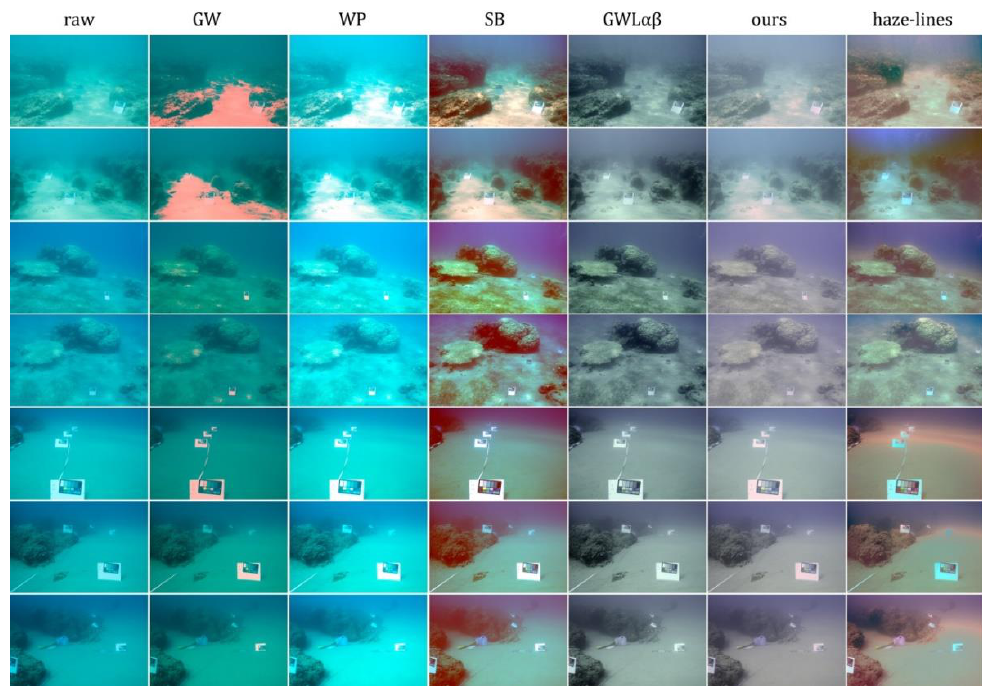
Figure 11. Comparisons on images in Haze-line dataset [13]. From left to right are raw underwater images, the results of gray-world (GW) method, white-patch (WP) method, statistical-based (SB) method [21], Bianco’s (GWLαβ) method [37], proposed method and haze-lines method [13]. Lower angular error indicates a more accurate color restoration. Many images in the Haze-line dataset contain multiple color charts at different distances from the camera. The charts are ordered by its distance to the camera and chart #1 is closest to the camera. The angular errors for each chart, image, and method are shown in Table 1. The lowest average angular error is got by our method, as evident from Table 1. Table 1. Angular error (unit: degrees) in RGB space between the gray-scale patches and a pure gray color, for each chart in each image, and all methods. Lower is better. From left to right are raw underwater images, the results of gray-world (GW) method, white-patch (WP) method, statistical-based (SB) method [21], Bianco’s (GWLαβ) method [37], proposed method and haze-lines method [13]. Image No. GW